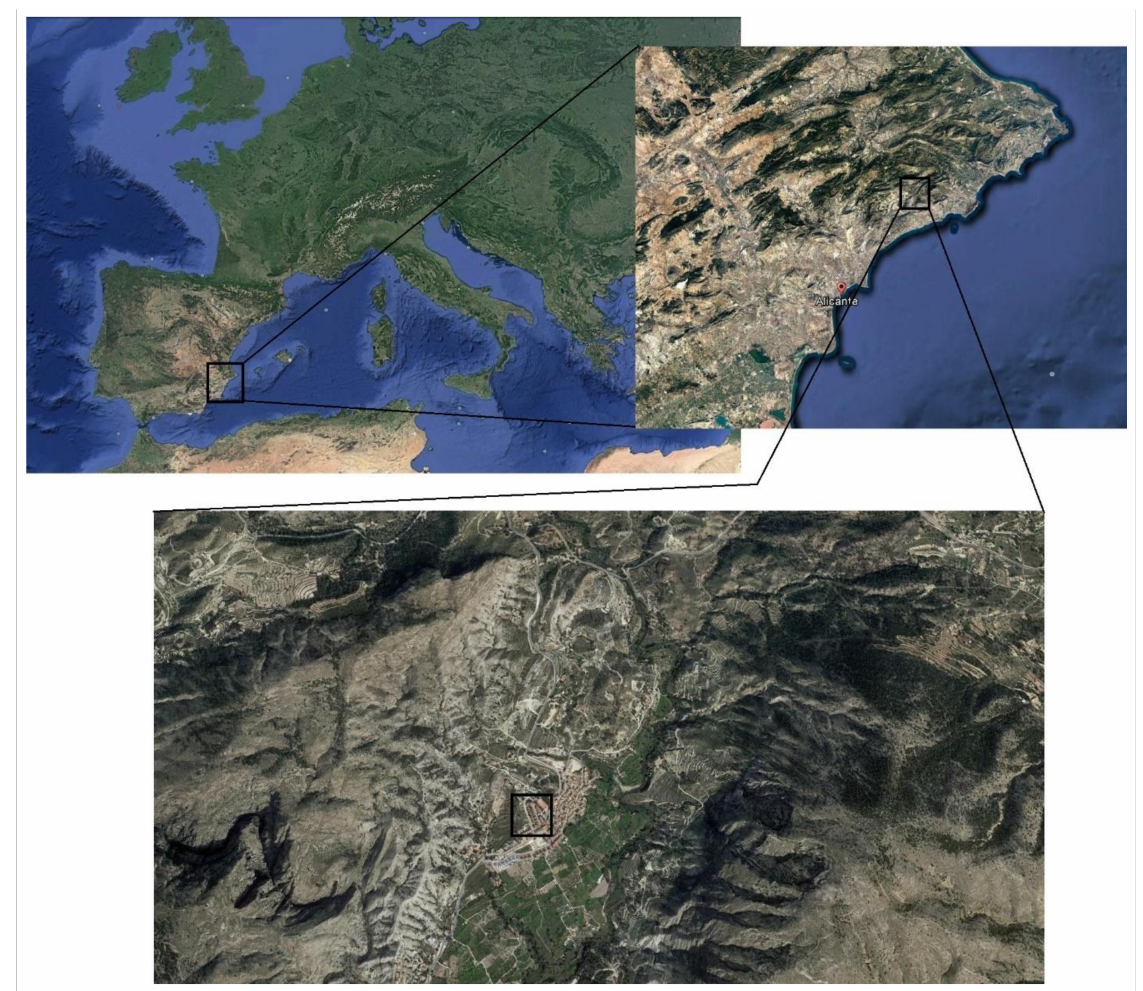
Figure 1. Location of the exposure site (black line squares). The specimens were placed on the roof of a detached house located in Orxeta town (Alicante province, Spain), and they were not protected from the weather conditions. The satellite images were obtained using the Google Earth software (Version 7.3.4, Mountain View, CA,